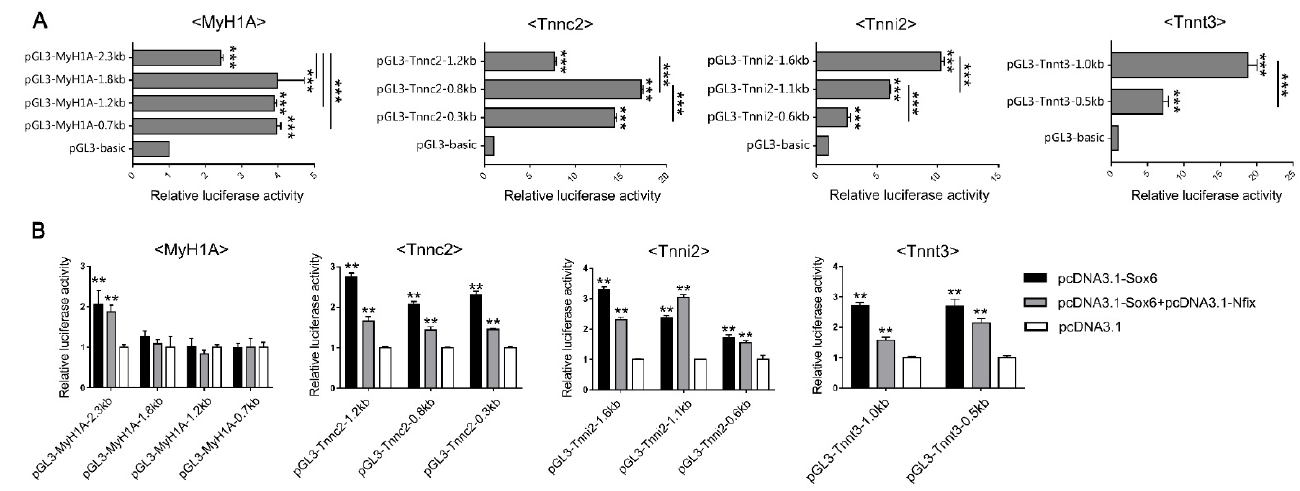
Figure 8. Sox6 directly promotes the transcription of fast-type isoforms. ( A ) Dual-Luciferase report assays on DF-1 transfected with reporter vectors containing different lengths of 5 ′ -upstream region of MyH1A , Tnnc2 , Tnni2 and Tnnt3 (mean ± SEM; *** p < 0.001; n = 6; one-way analysis of variance with Tukey’s multiple comparison test). ( B ) Dual-Luciferase report assays on DF-1 overexpressing Sox6 and Nfix and transfected with reporter vectors containing different lengths of 5 ′ -upstream region of MyH1A , Tnnc2 , Tnni2 and Tnnt3 (mean ± SEM; ** p < 0.01; n = 6; one-way analysis of variance with Tukey’s multiple comparison test).